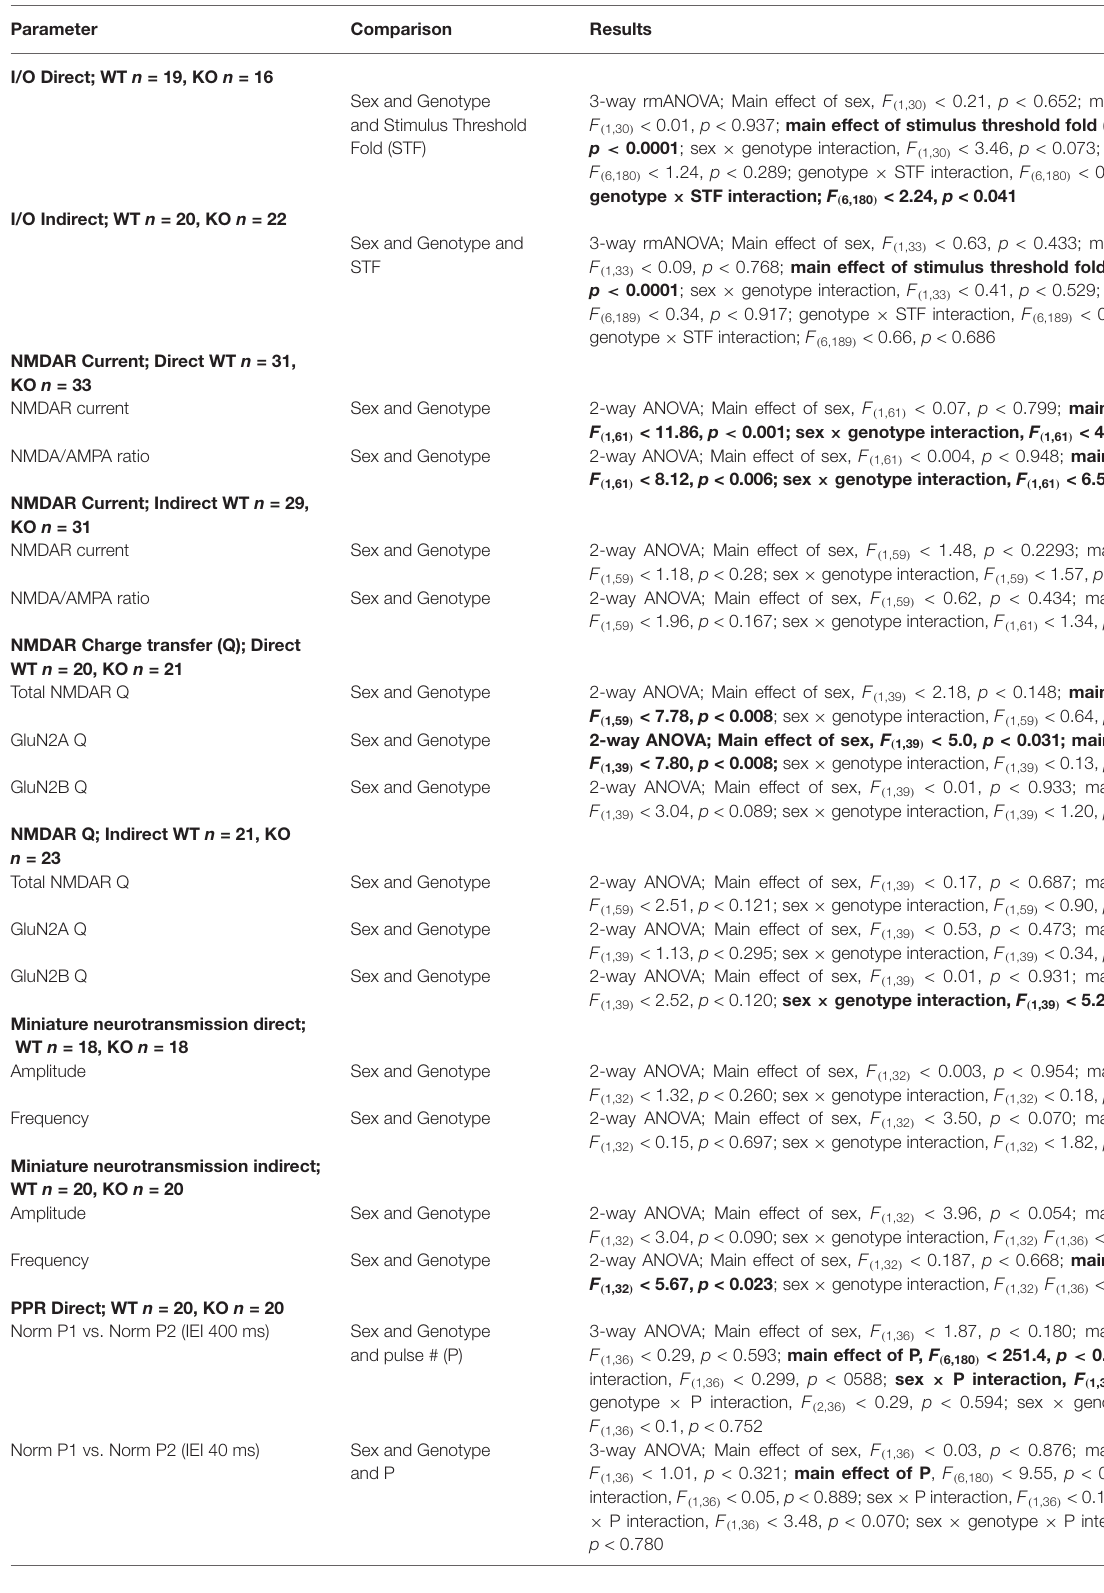
TABLE 1 | Analysis of variance for electrophysiological studies. Parameter Comparison